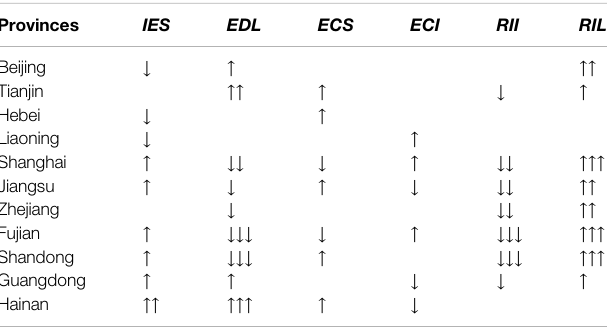
TABLE 5 | Analysis of the critical paths to improving the industrial TCP in eastern China.